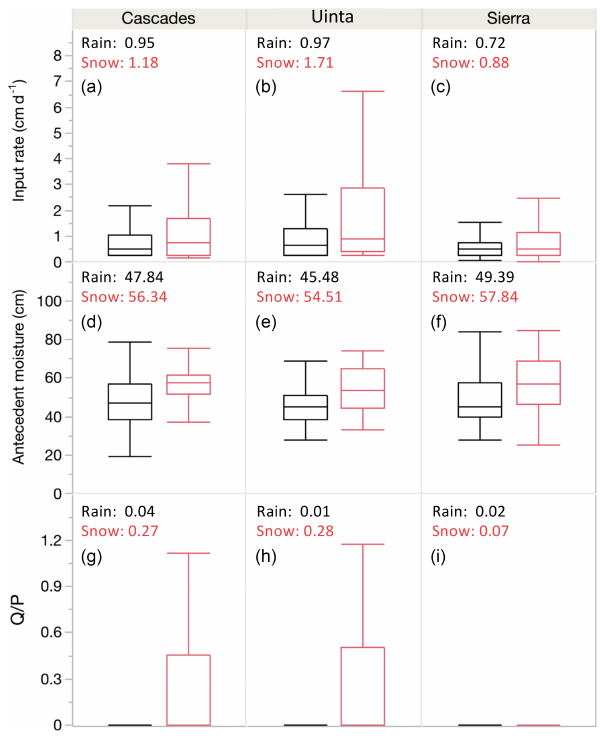
Figure 4. Boxplots of event input rate (cmd − 1 ) (a–c) , antecedent soil moisture storage ( S , cm) (d–f) , and event runoff ratio ( Q/P , g– i ) by region and event type (rain black, snowmelt red). The text in each subplot gives mean values. All ANOVA comparisons between values for rain and snowmelt have p values < 0.0001. Results from historical simulations on loam